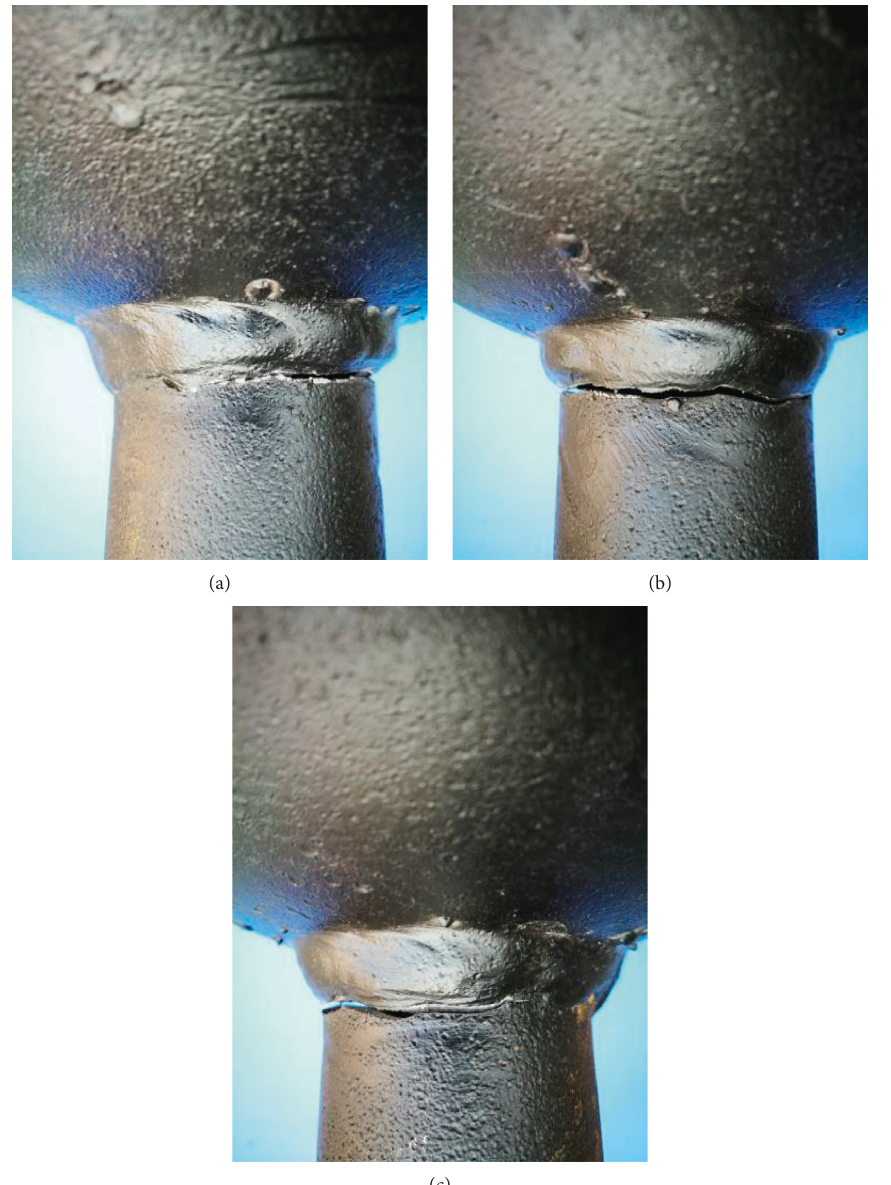
Figure 9: Typical fatigue failure mode (stress amplitude � 170MPa; stress ratio � 0). Left side (a), center (b), and right side (c) of the